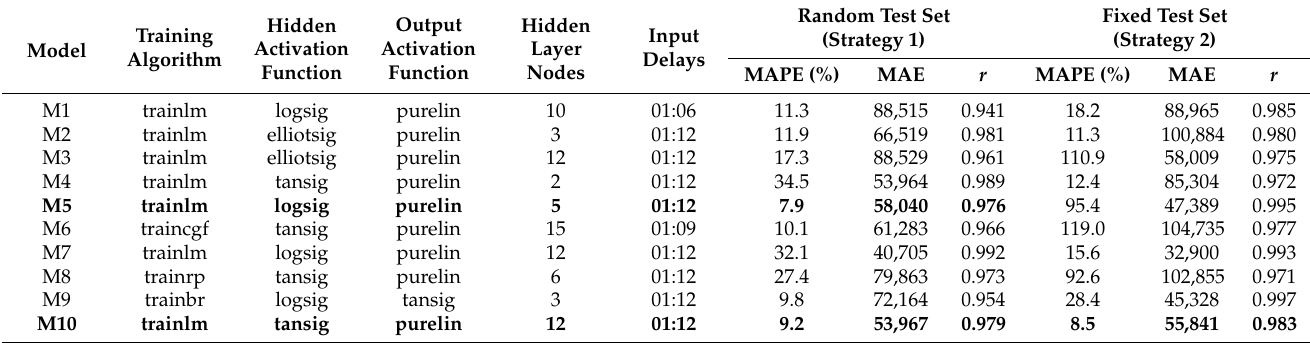
Table 3. Comparison of the prediction models performance. The best models are in bold.